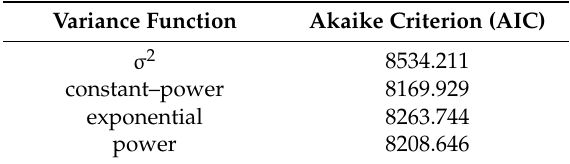
Table 4. Fitting statistics of the simple mixed model (MM1), using different types of variance functions.